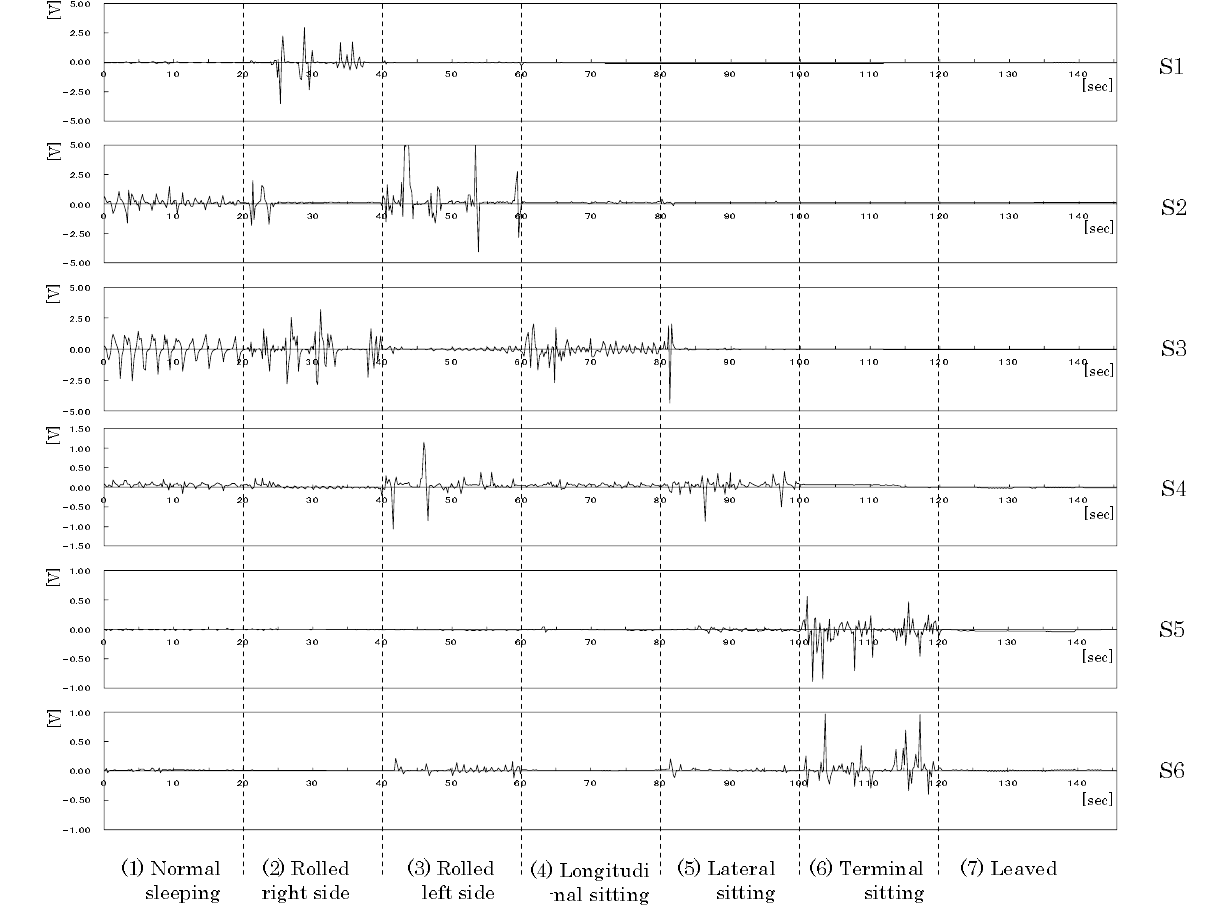
experiment. We optimized these thresholds based on results of our preliminary experiments of 10 times. Figure 8 depicts histograms of fuzzy definite values and in each status.